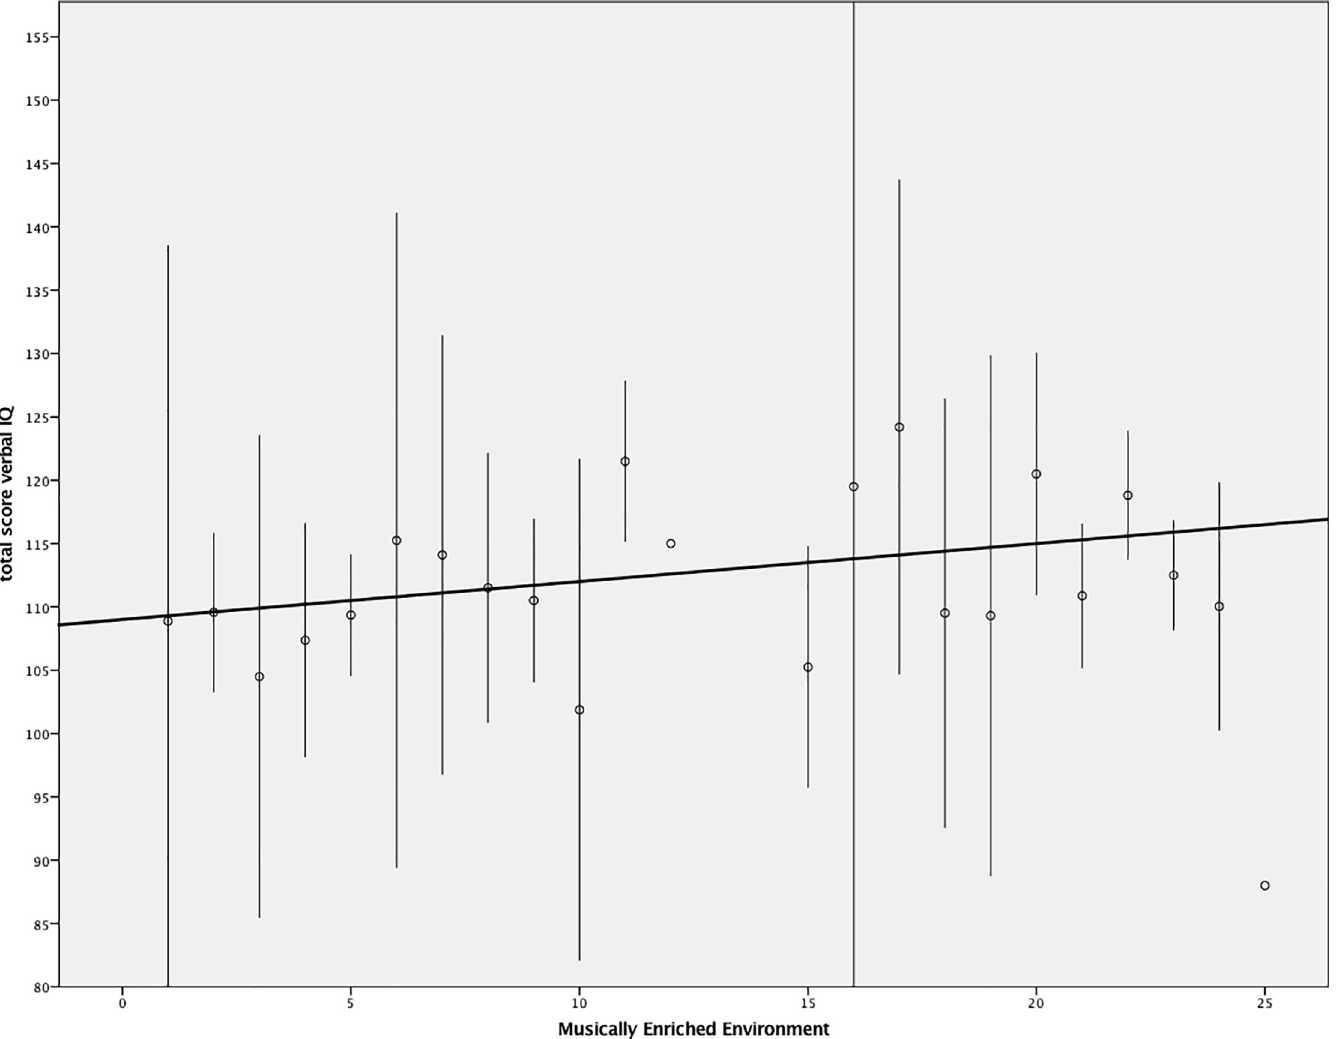
Fig 1. Distribution of individual WISC-III scores in relation to a MEE. Fig 1 shows the distribution of intelligence scores compared to participants across different gradations of experiencing a MEE as computed by the regression model. Vertical lines represent distribution across participants. The diagonal line depicts the differences in predicted values between the MEE intake questionnaire score and verbal intelligence as measured by the WISC III.